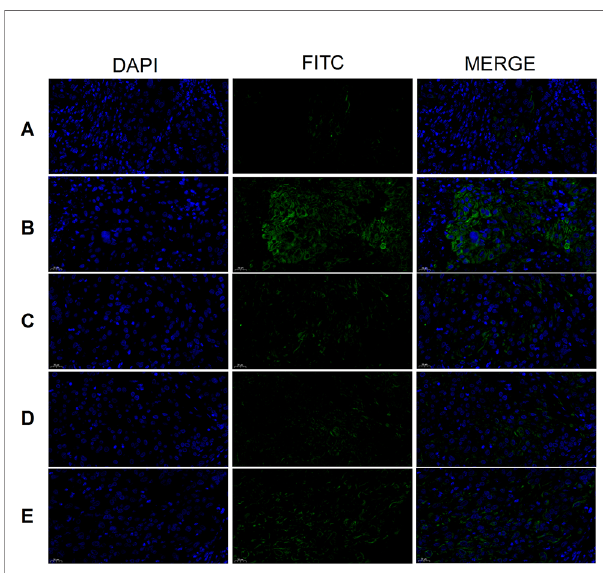
FIGURE 9 | CD117 expression (×400). Model group (A) , cisplatin group (B) , THSWD H group (C) , THSWD M group (D) , THSWD L group (E)